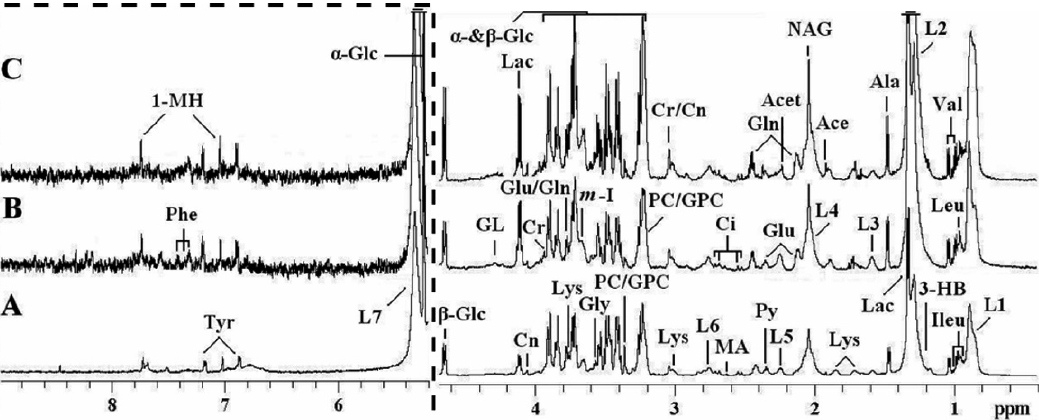
Figure 1 - 600-MHz 1 H NMR spectra ( d 0.4-4.7 and d 5.2-9.0) of serum obtained from the (A) control, (B) IgAN-A and (C) IgAN-B groups. The region of d 5.2-9.0 (in the dashed box) was magnified 8 times compared with the corresponding region of d 0.4-4.7 for the purpose of clarity. Key: 1-MH: 1-Methylhistidine; Ace: Acetate; Acet: Acetone; Ala: Alanine; Ci: Citrate; Cr: Creatine; Cn: Creatinine; GL: Glycerol of lipids; Gln: Glutamine; Glu: Glutamate; Gly: Glycine; GPC: Glycerolphosphocholine; Ileu: Isoleucine; L1: LDL&VLDL, CH 3 -(CH 2 ) n -; L2: LDL&VLDL, CH 3 -(CH 2 ) n -; L3: -CH 2 -CH 2 -C=O; L4: -CH 2 -CH=CH-; L5: -CH 2 -C=O; L6: =CH-CH 2 -CH=; L7: -CH=CH-; Lac: Lactate; Leu: Leucine; Lys: Lysine; MA: Methylamine; m -I: myo -Inositol; NAG: N-acetyl glycoprotein signals; PC: Phosphocholine: Phe: